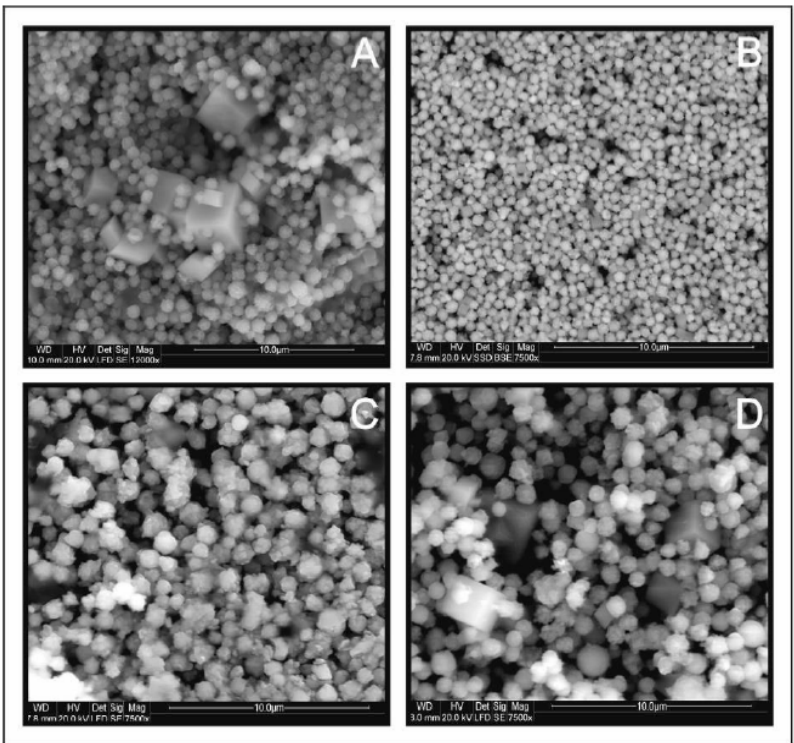
Figure 8. Scanning electron microscopy images for Cu 2 MnSnS 4 (CMTS) resulting from different times of synthesis: ( A ) 1 day, ( B ) 3 days, ( C ) 1 week, ( D ) 2 weeks. The particle size depends on the synthesis time and the optimal reaction time is one week.